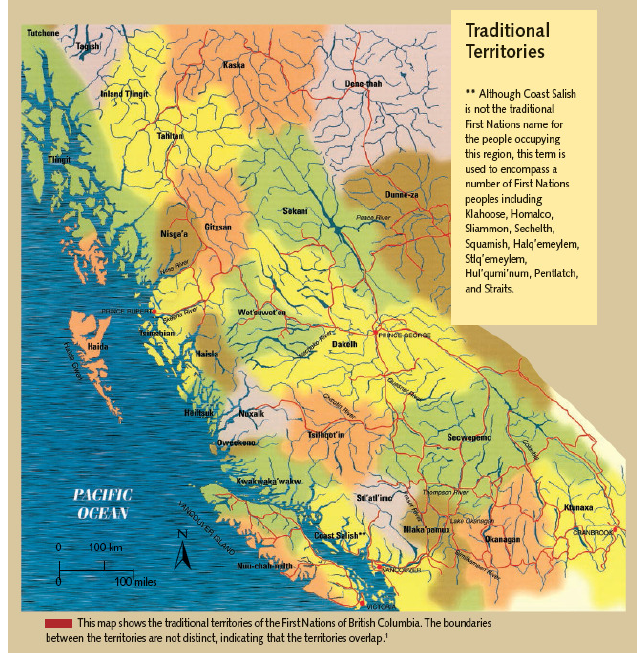
Figure 3: Map of traditional territories of BC First Nations. Source: BC First Nations Studies (Campbell, Menzies, and Peacock 2003, 19). Image reproduced under the Fair Use Doctrine. Available via Open School BC: